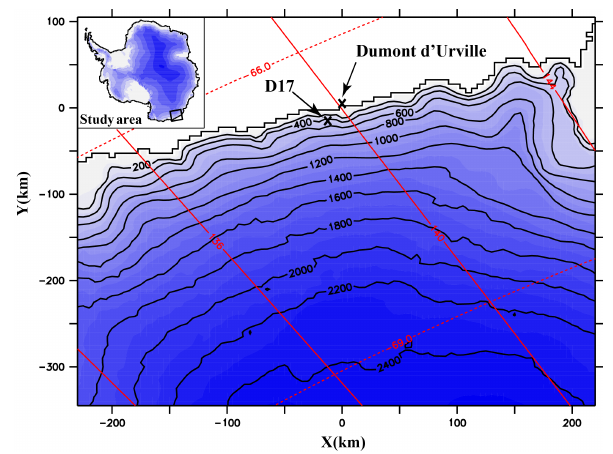
Figure 1. Map of Adélie Land showing the location of Dumont d’Urville station and measurement site D17. Contour lines are in meters.